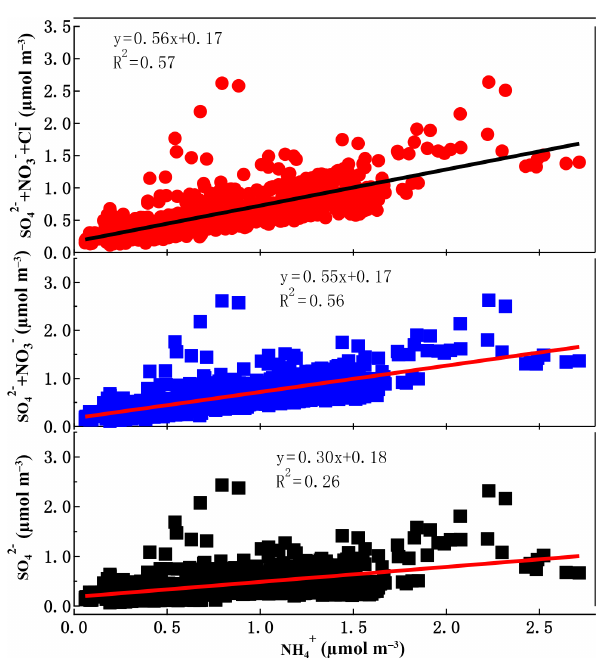
Figure 4. Correlation of observed NH + + NO − SO 2 − , and SO 2 − 4 3